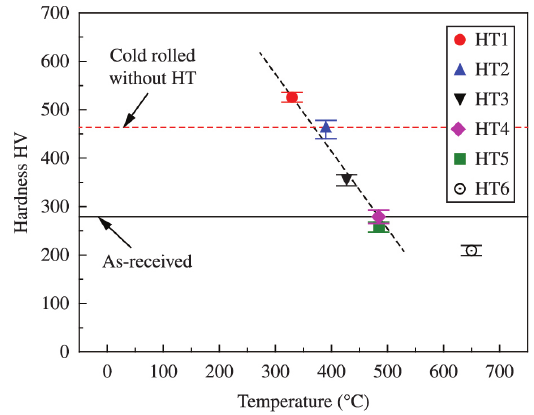
Figure 3. Microhardness vs. Temperature for each heat